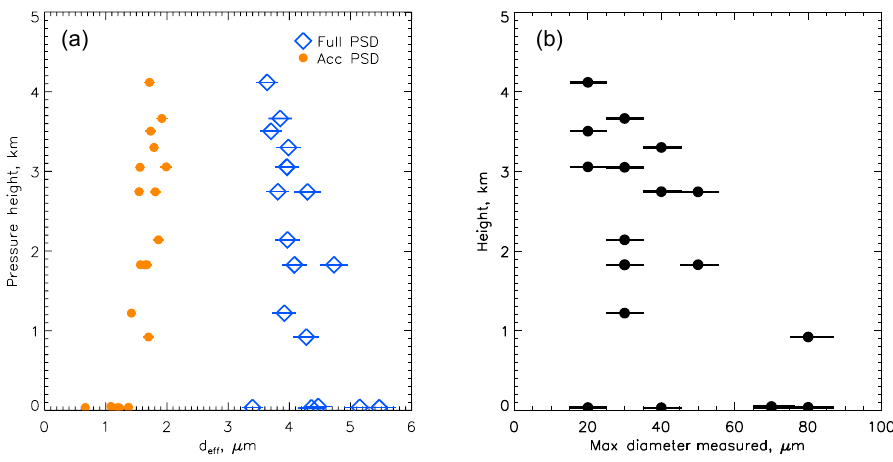
Figure 8. Variation in size with altitude for SLRs: (a) effective diameter; (b) maximum diameter measured by the 2-DS XY instrument. Orange circles represent accumulation mode only; blue diamonds represent the FULL